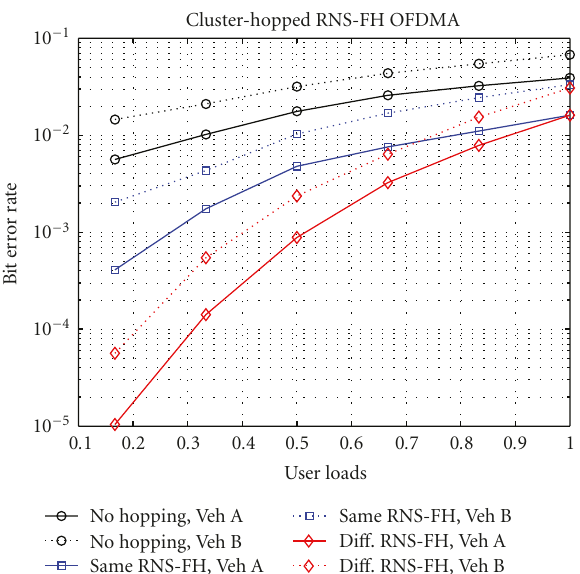
Figure 13: Performance of cluster-hopped RNS-FH OFDMA with di ff erent cluster sizes and di ff erent number of active users, f D T s = 0 .